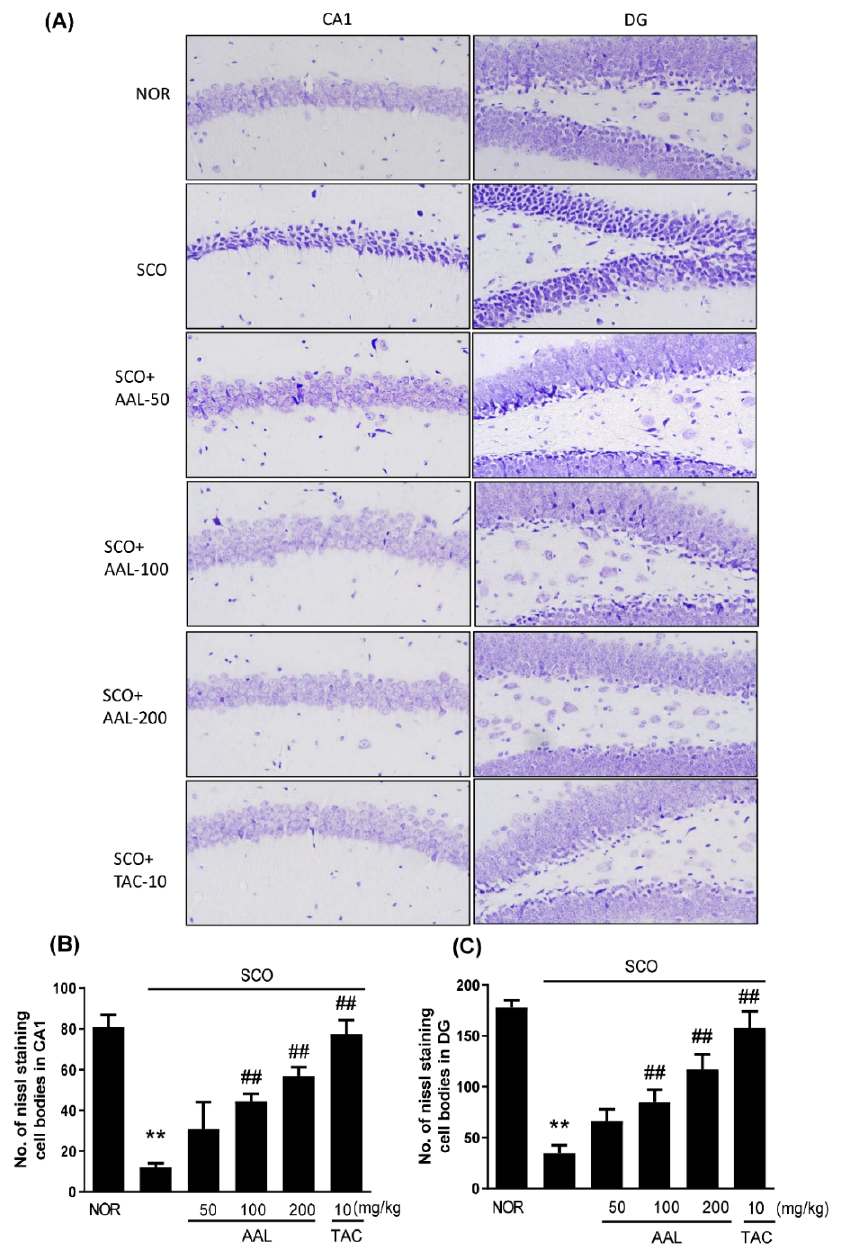
Figure 3. Effect of AAL extract on the morphological damage to neurons in scopolamine-induced cognitive deficit mouse brains. Sections of the hippocampus, including the CA1 and DG regions, were prepared for Nissl staining using cresyl violet solution. Representative photomicrographs are shown at magnifications of ×400 ( A ). The graph shows the number (No.) of Nissl stained cells in the CA1 and the DG ( B and C , respectively). CA: Cornu Ammonis; DG: dentate gyrus, Data are presented as the mean ± SEM ( n = 3). ** p < 0.01 vs. NOR group, ## p < 0.01 vs. SCO group. NOR: normal control; SCO: scopolamine; AAL: A. atemoya leaf ; TAC: tacrine.